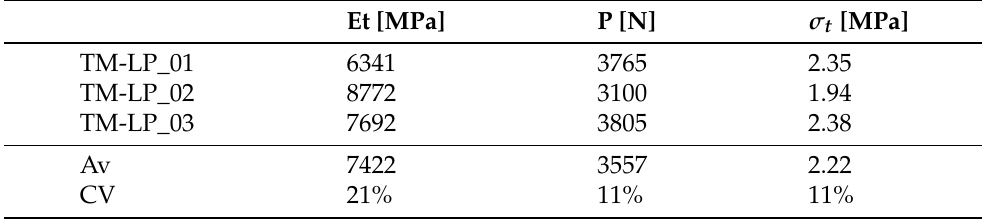
Table 1. Results of uniaxial tensile tests (TM-LP) for the determination of Young’s Modulus in tension, E t . P is the maximum force and σ t is the maximum tension stress.